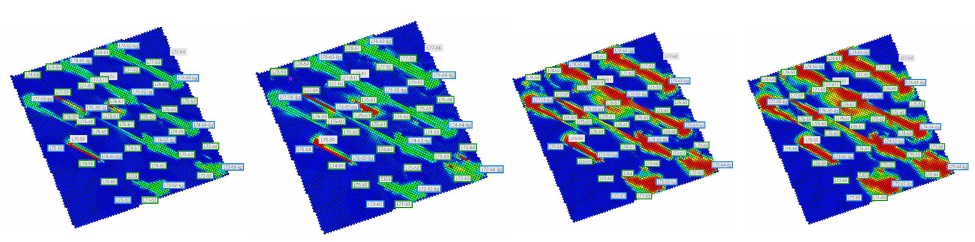
Figure 8. Effect of the gas injection volume on the dynamic production performance.